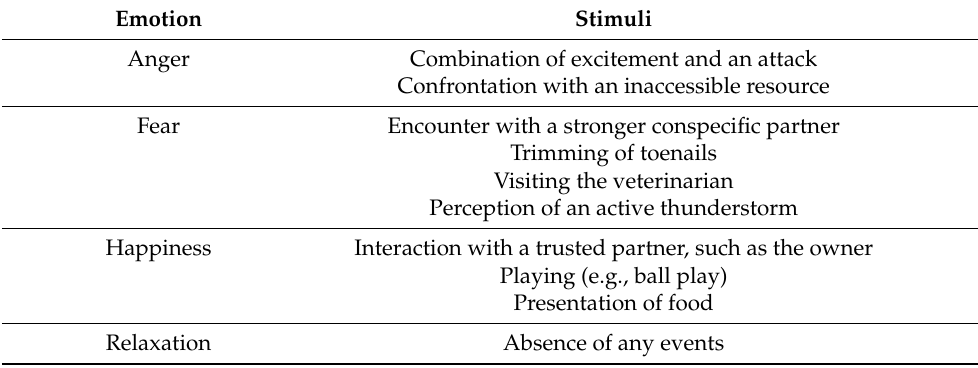
Table 1. Mapping of target emotions to different stimuli [3,13,21–23].